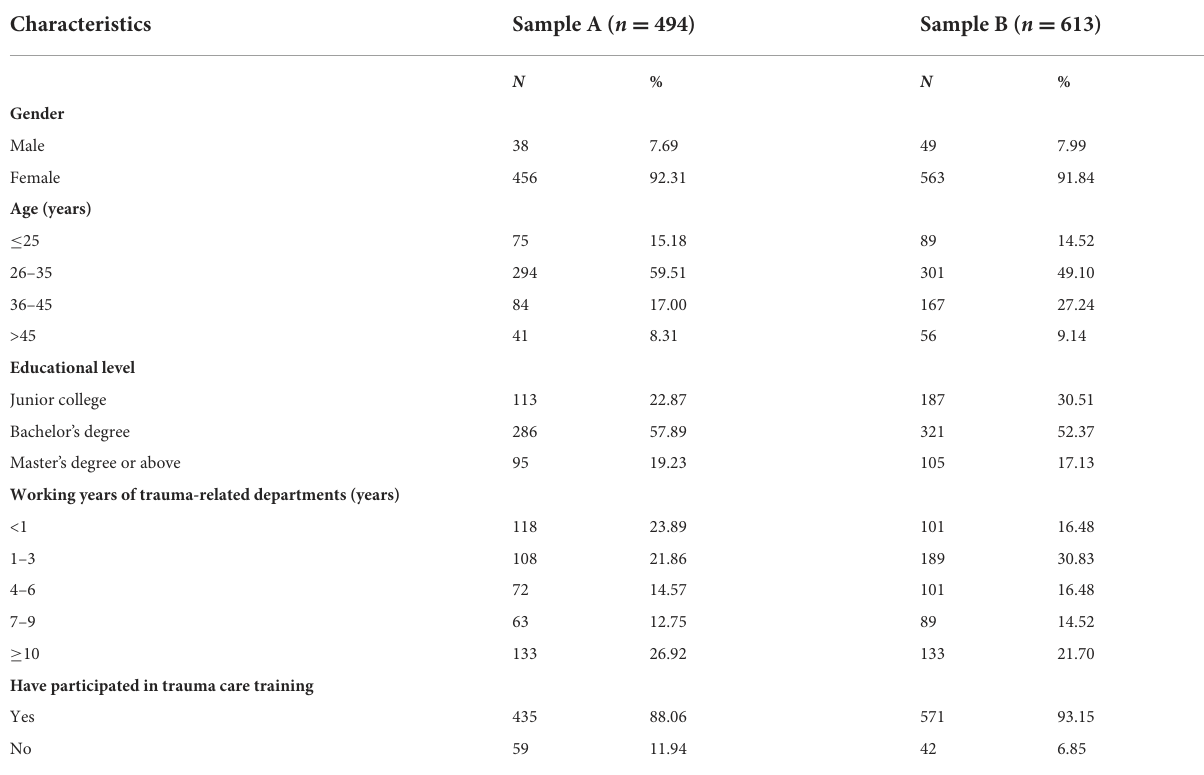
was 0.91, indicating a high correlation among items, and thus a factor analysis could be performed ( p < 0.001). The results of the factor analysis were shown in Table 3. Totally three components were retrieved, which together accounted for 75.24% variance and explained with eigenvalue from 1.20 to 30.99 (Shown in Table 3). The commonality among the 46 items was between 0.61 and 0.84. The factor loadings were from 0.56 to